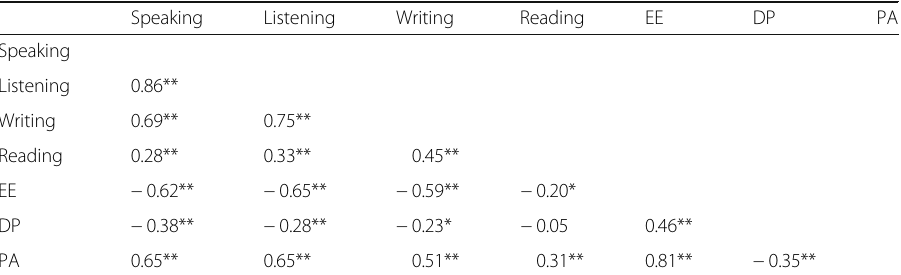
Table 3 Correlations between the language proficiency subskills and burnout dimensions Speaking Listening Writing Reading EE DP